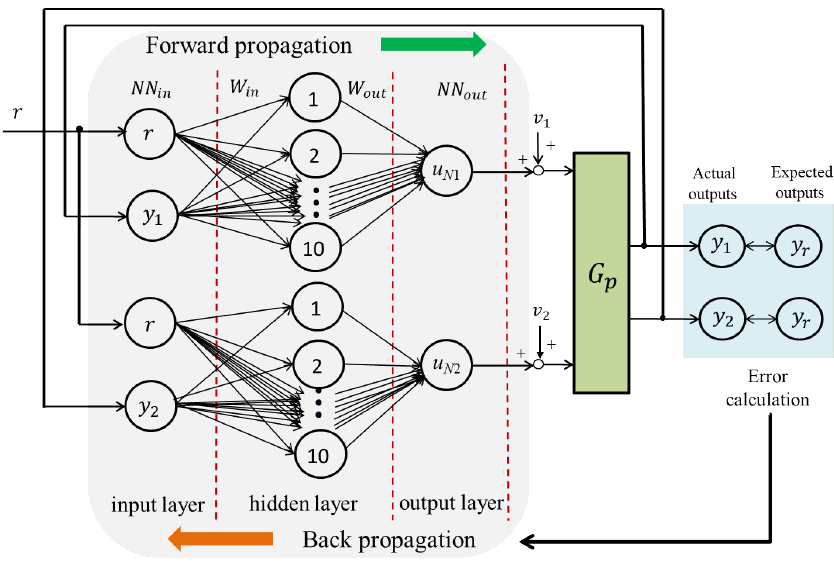
Figure 5. Structure of the multi-layer neural network